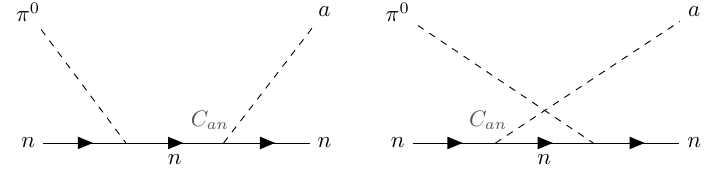
Figure 1 . Diagrams for π − + p → n + a from the axion couplings in eq. (2.9).